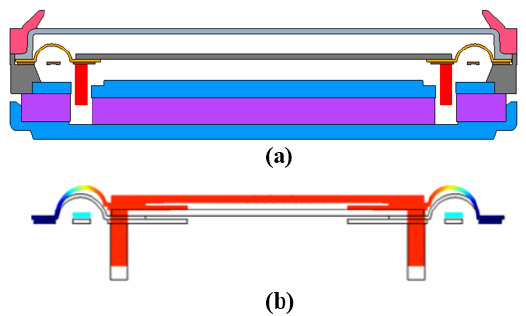
Figure 4. Vibration mode: ( a ) cross-section view of microspeaker unit and ( b ) the vibration mode of diaphragms and voice coil.